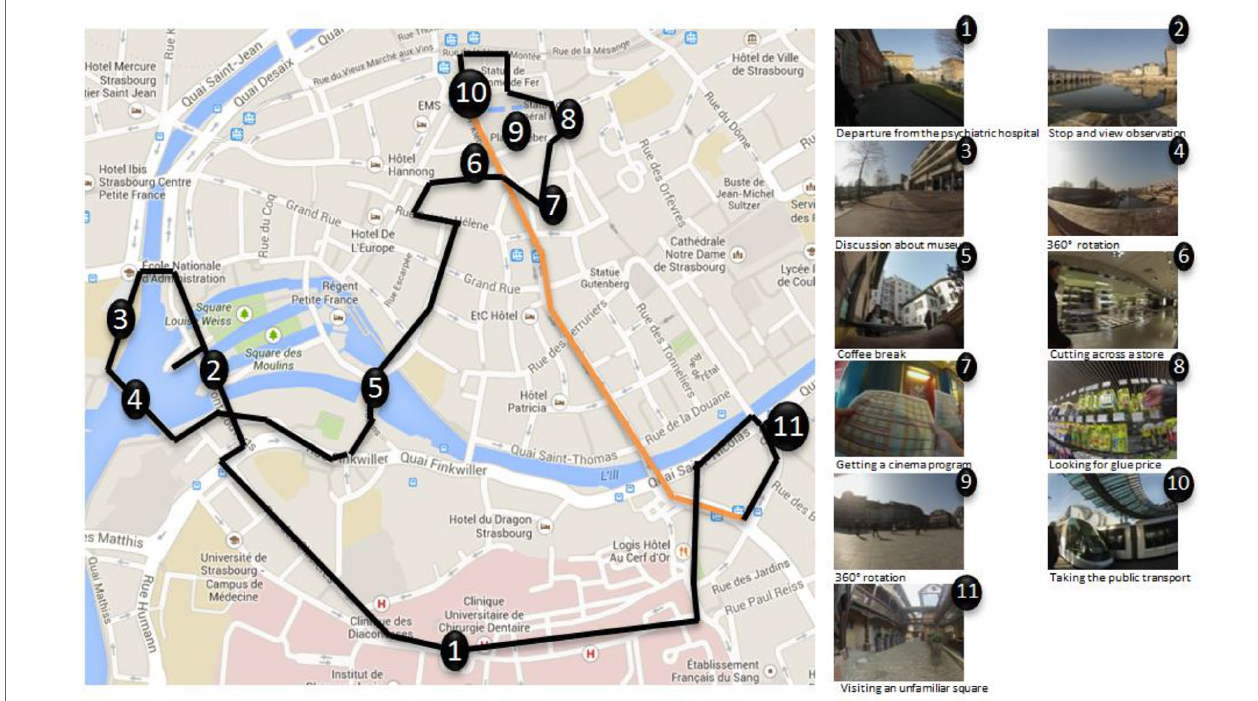
FIGURE 1 | Overview of the walk on the city center of Strasbourg (France). The numbers represent the locations in which activities were performed, black lines represent the walk between each activity, and the orange line represents public transport use. For each numbers, an example of pictures taken by the wearable camera during the activity is provided. Map data copyright: Google,